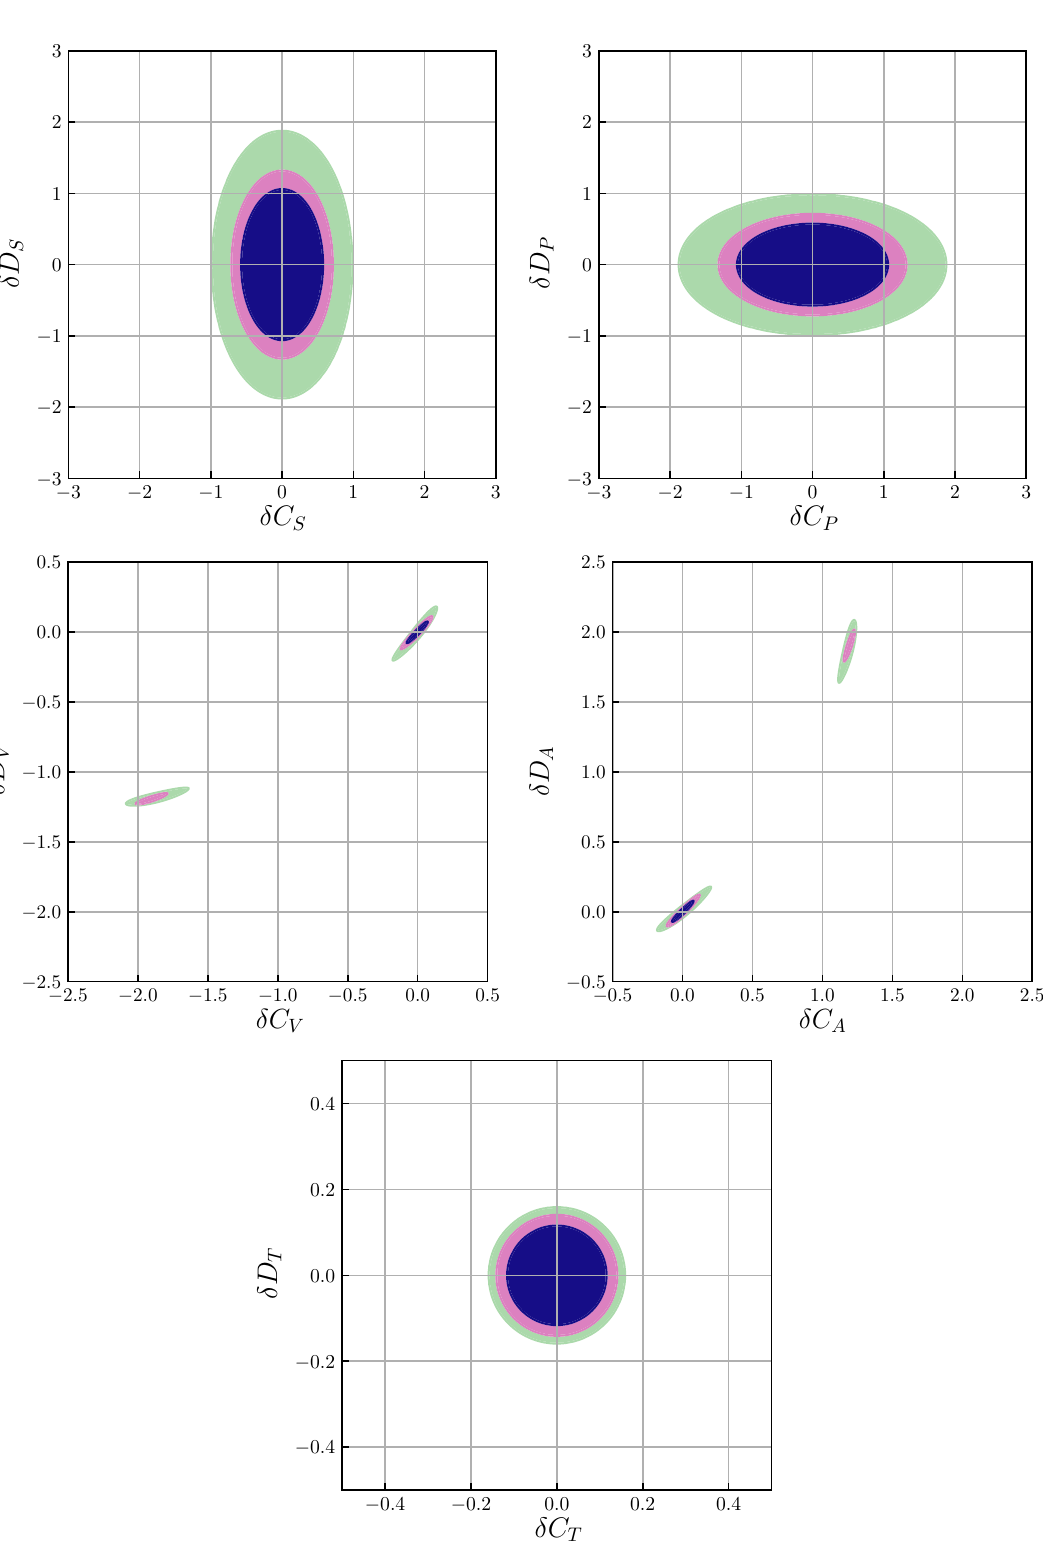
Figure 5 . Constraints on the SPVAT parameters. The color coding is the same as figure